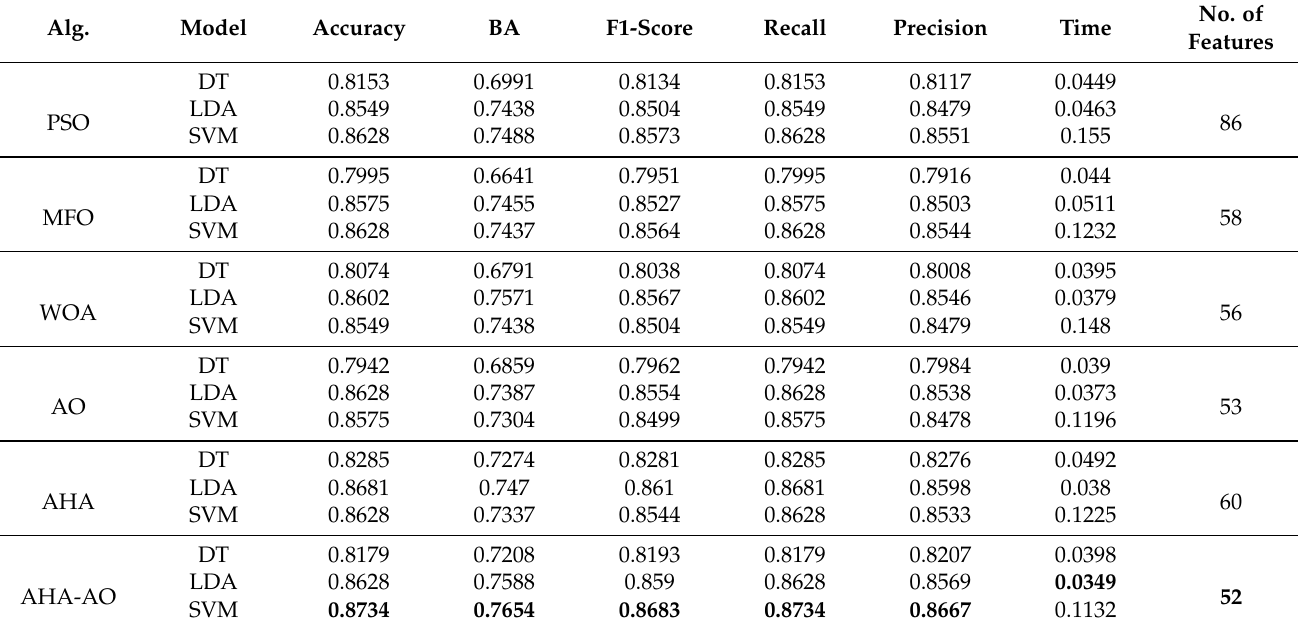
Table 4. Classification results of each feature selection optimization algorithm on the ISIC-2016 dataset (bold refers to best